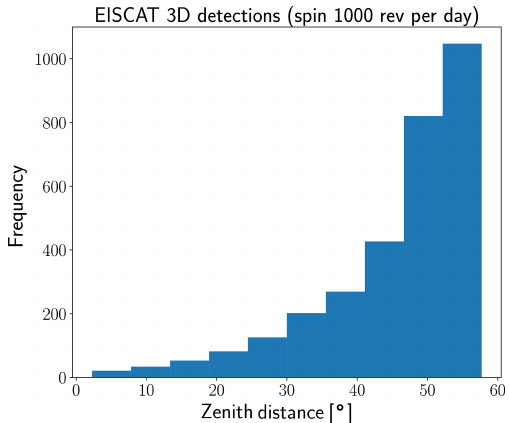
Figure 10. The zenith angle distribution of all possible observation windows, assuming a rotation rate of 1000 revolutions per day and that a prior orbit is available.